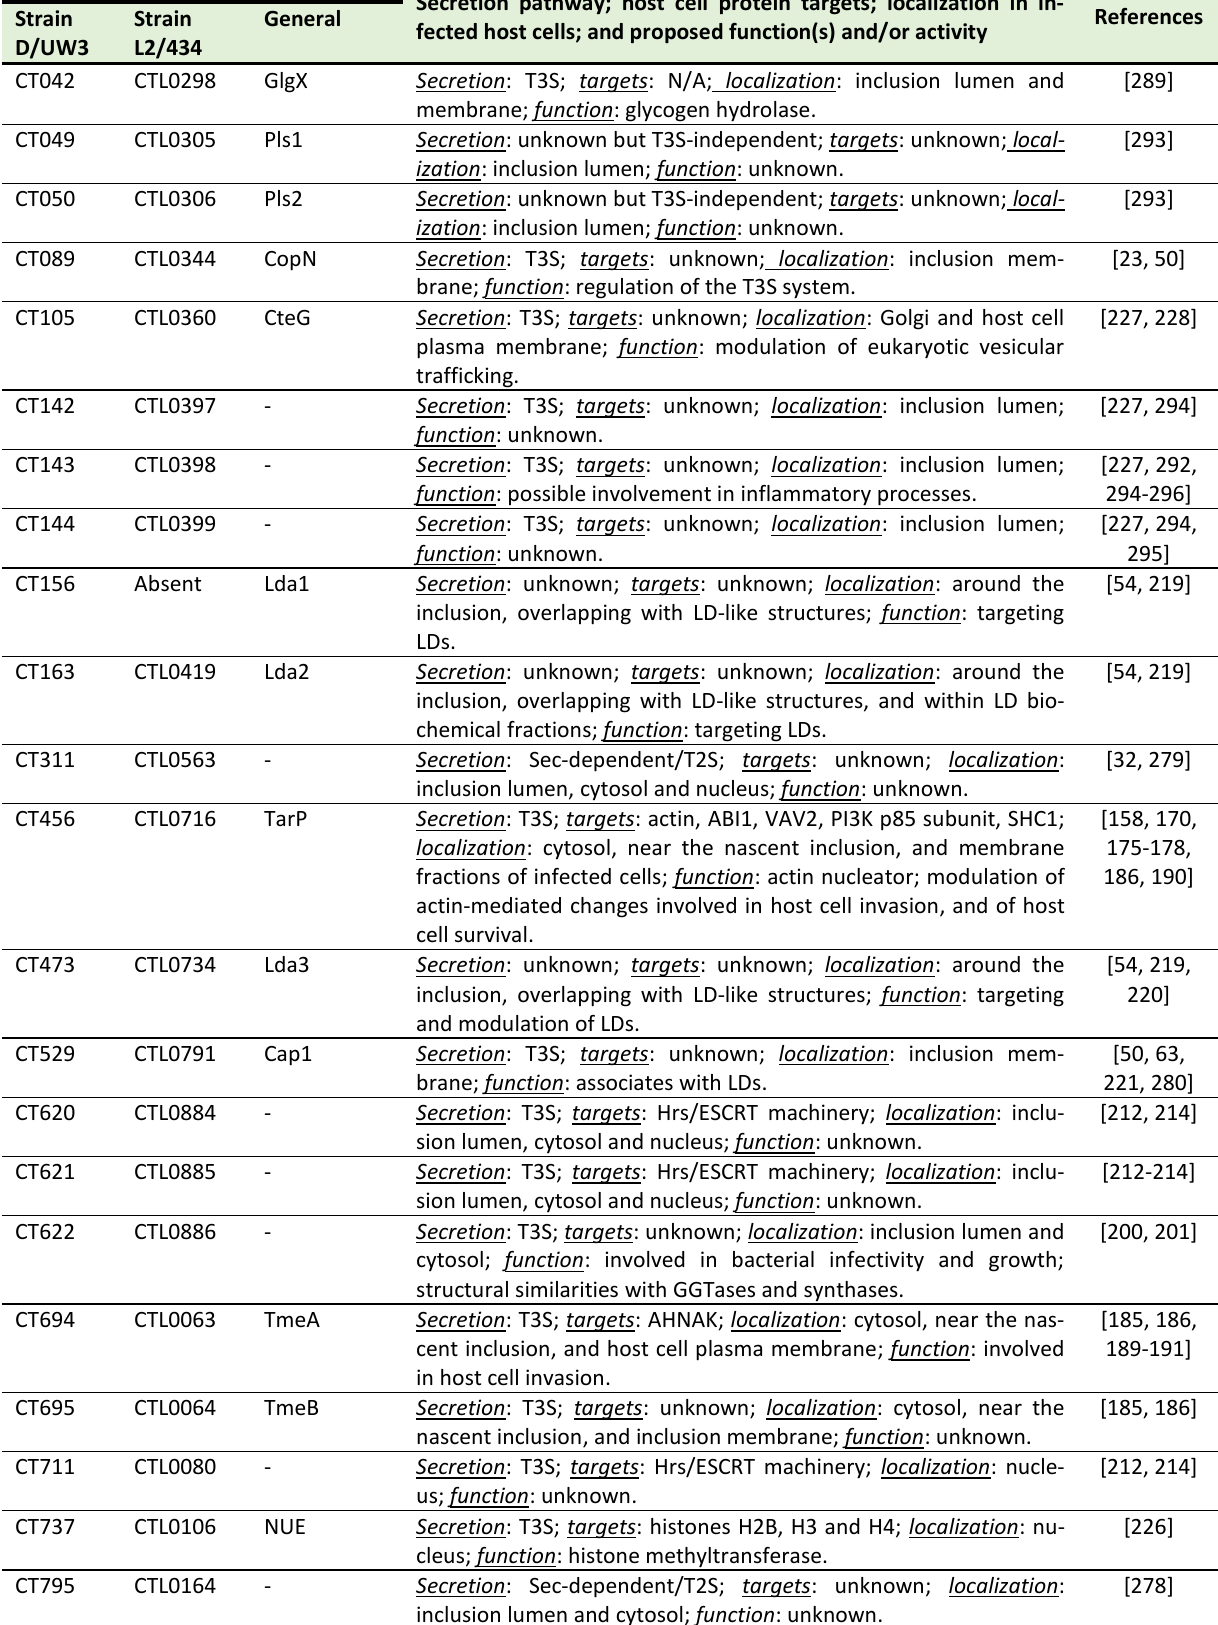
TABLE 2: C. trachomatis non-Inc proteins secreted into the host cell cytoplasm, inclusion membrane, or inclusion lumen a . Protein